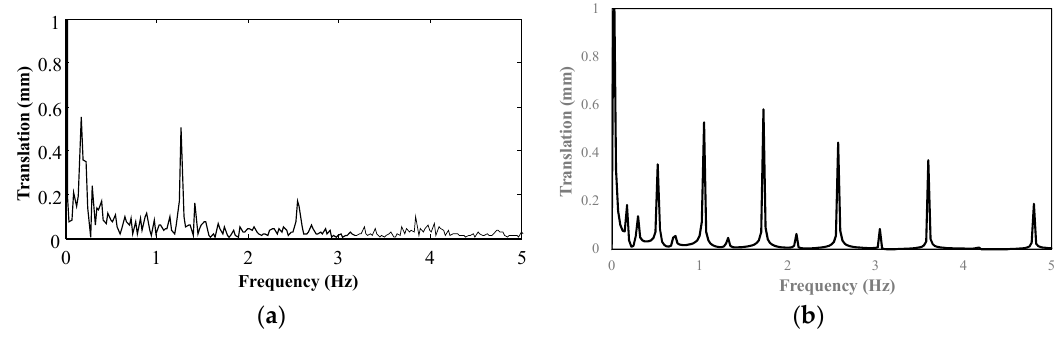
Figure 9. Frequency response analysis of continuous steel plate. ( a ) Experiment result ; ( b ) Analysis result